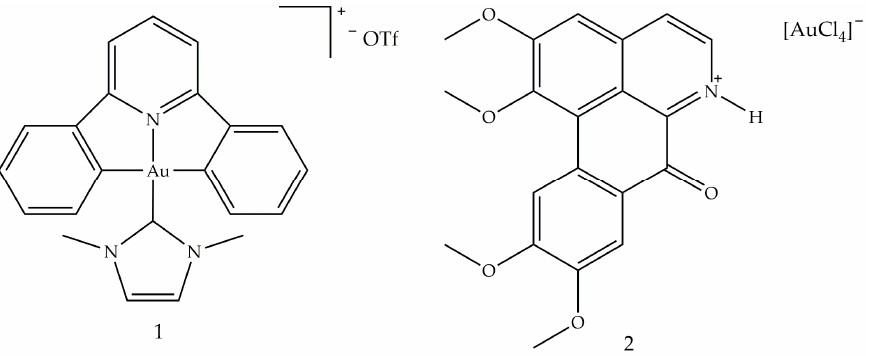
Figure 3. Molecular structure of [Au(CˆNˆC)(IMe)]CF 3 SO 3 ] ( 1 ) and [OGH][AuCl 4 ] ( 2 ) [60]. Abbreviations: CˆNˆC is the bi-cyclometallated di-anionderived from 2,6-diphenylpyridine, IMe is N,N’-dimethylimidazolium and [OGH](+) is the charged alkaloid oxoglaucine (OG).